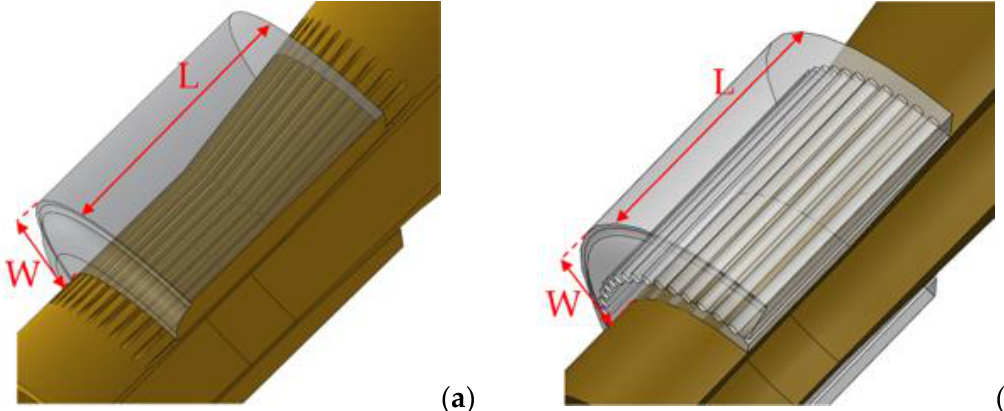
Figure 4. Sketch of the geometry of the two mock-ups equipped with MCs: configuration A with semicircular + rectangular section ( a ), and configuration B with circular section ( b ). For both mock-ups, L = 43 mm and W = 12 mm.